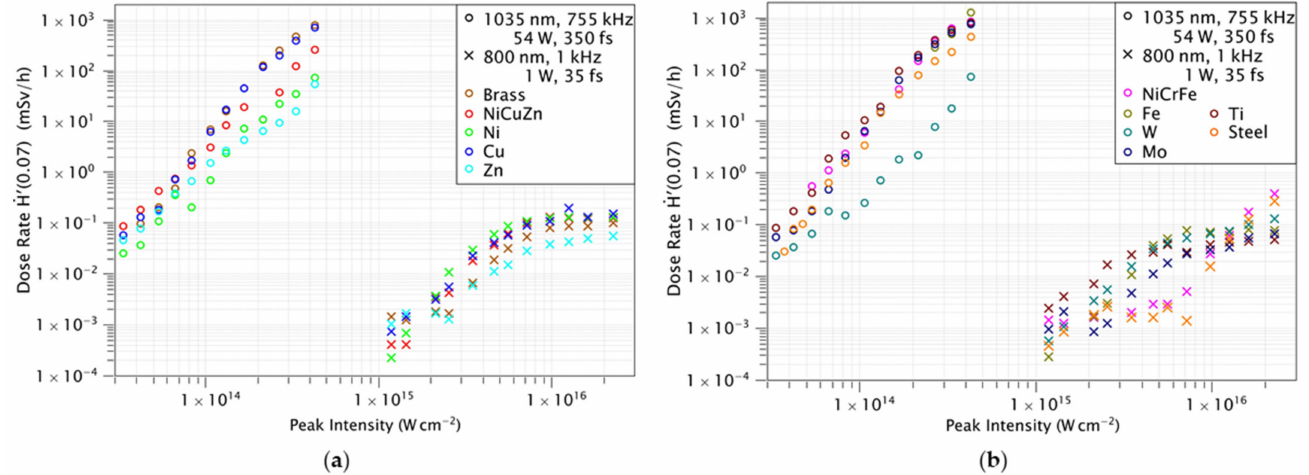
Figure 3. Measured dose rates ˙H (cid:48) (0.07) in dependence on the different target material and the incident laser peak intensity listed as: ( a ) Brass, and NiCuZn alloy and its composition metals Ni, Cu, and Zn are investigated using the ionization chamber dosimeter OD-02 at a distance of 150 mm from the interaction zone in air. The laser intensity was varied between 5 × 10 13 and 5 × 10 16 W/cm 2 by tuning the laser pulse energy for two different lasers. ( b ) NiCrFe and stainless steel alloys and its composition metals as well as W, Mo, and Ti are plotted in the same experimental